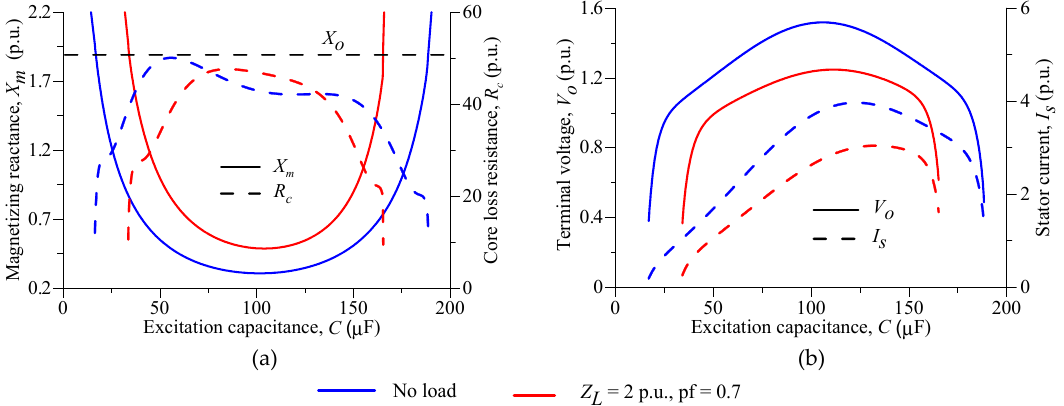
ZL = 2 p.u., pf = 0.7 Figure 7. Variation versus excitation capacitance C for different loads at fixed speed ( u = 1.0 p.u.): ( a ) Magnetizing reactance X m and core loss resistance R c ( b ) Terminal voltage V o and Stator current I s .